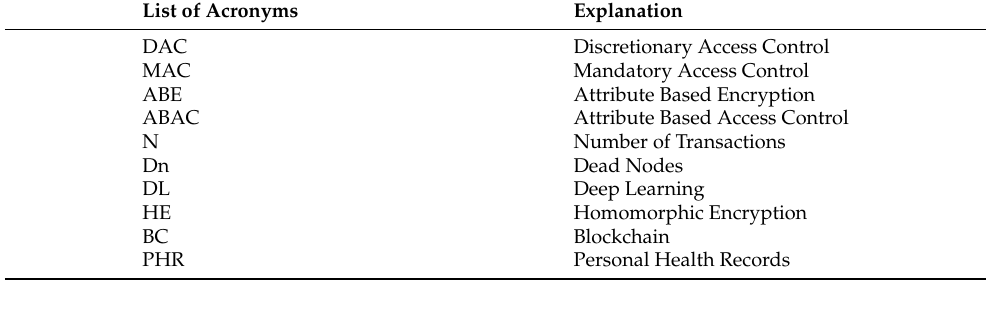
Table 1. List of Proposed Acronym used.